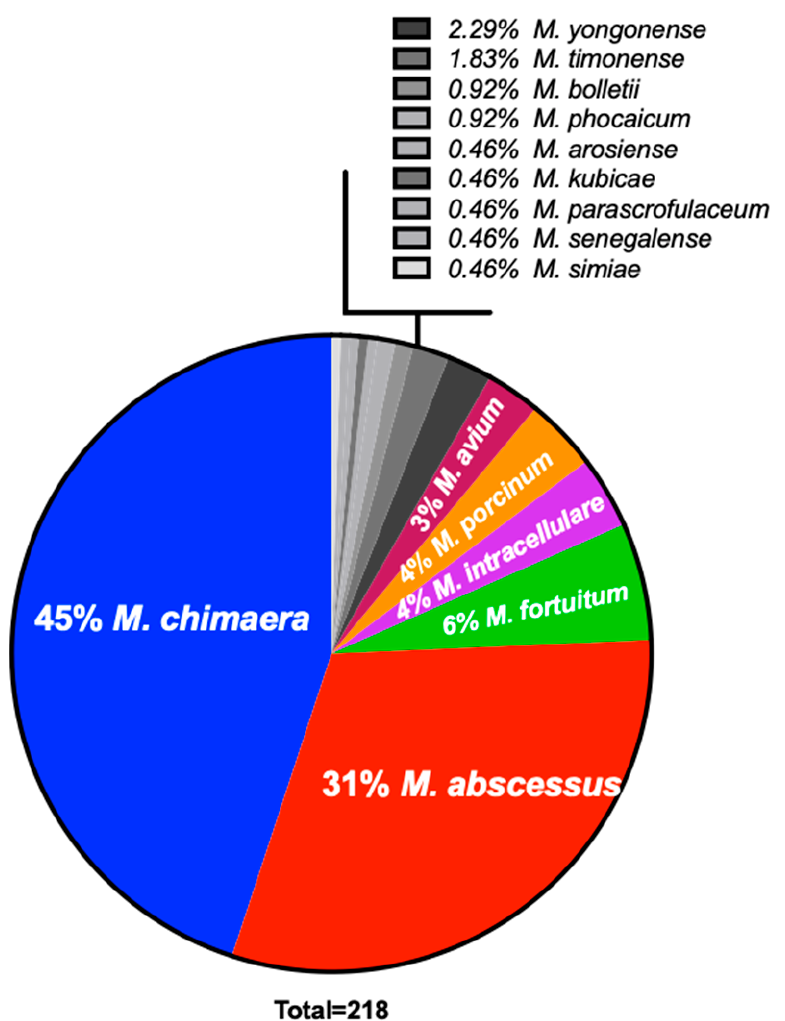
Figure 1. M. chimaera predominates clinical respiratory specimens from Hawai’i. NTM respiratory isolates were obtained from 218 de-identified Hawai’i patients with suspected mycobacterial lung infection. M. chimaera was the most commonly identified, followed by M. abscessus, M. porcinum, M. fortuitum, M. intracellulare and M. avium.